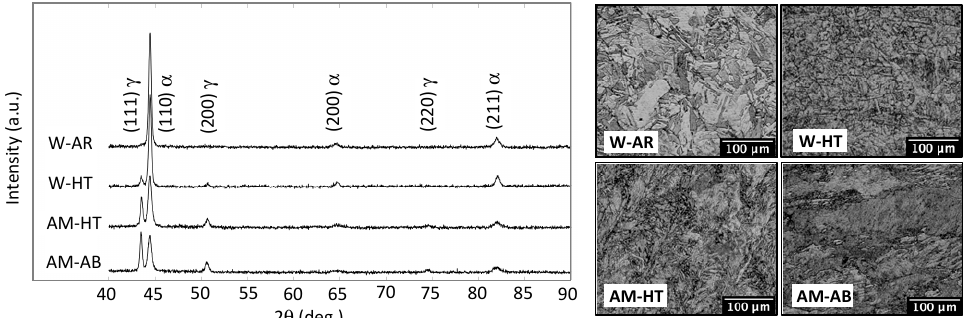
Figure 5. XRD spectra and micrograph from within the un-strained grip location.